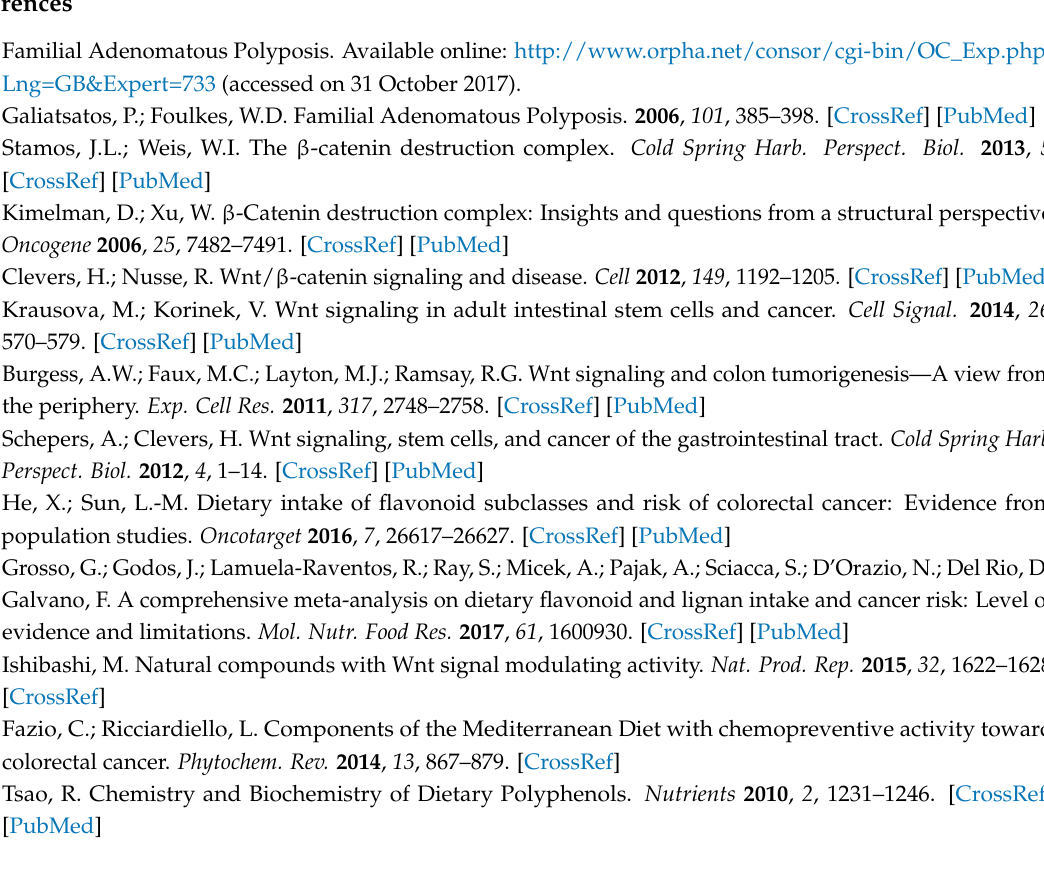
Figure S1: Description of the biological platform used to measure the activity of canonical WNT/ β -catenin signaling in HEK293 cells, Figure S2: AAE and LAE inhibit WNT/ β -catenin signaling in HEK293 cells, Figure S3: WNT/ β -catenin pathway activity in CaCo-2